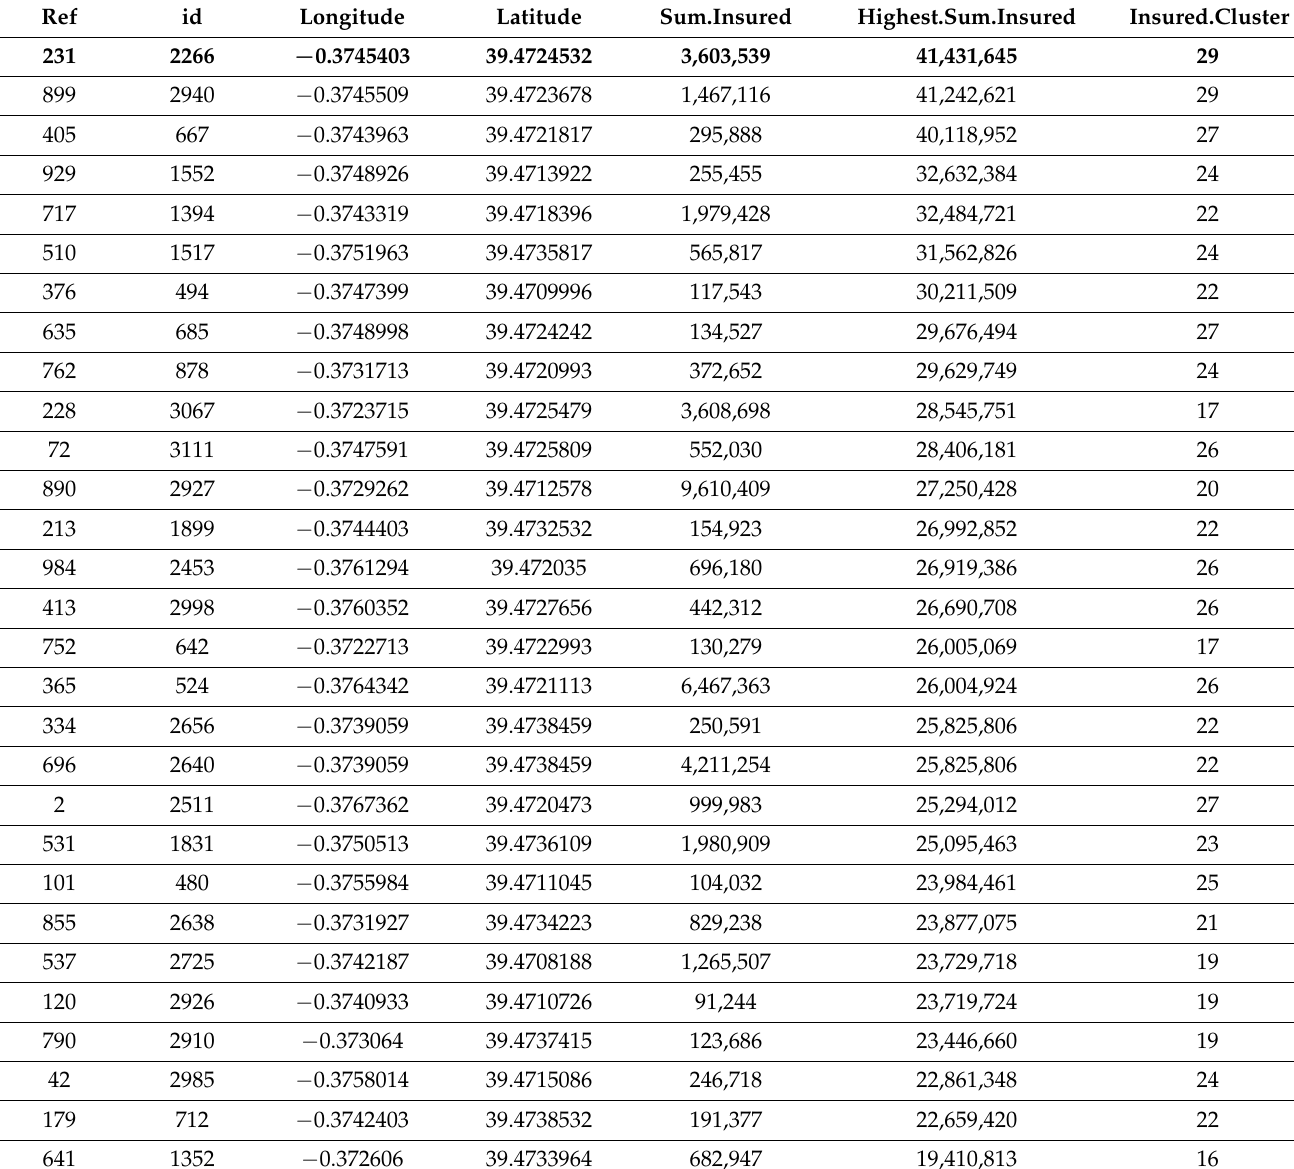
Table 2. The highest risk cluster for the insurance